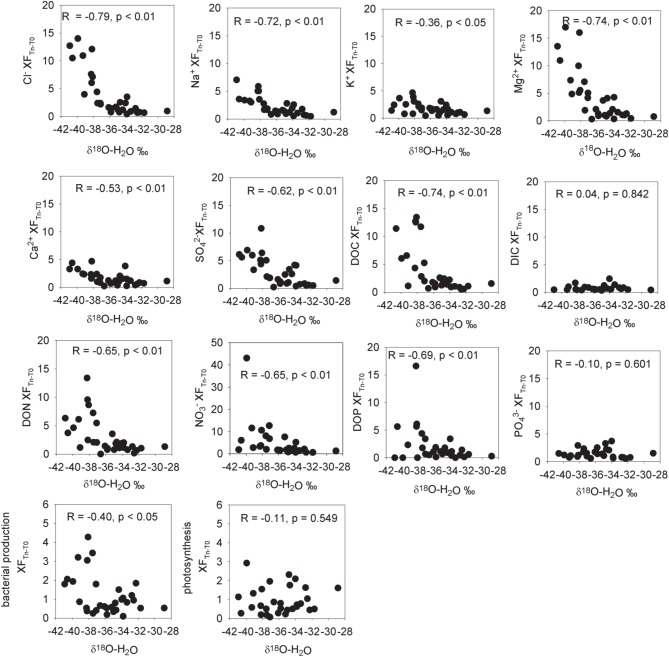
Enrichment factors (XF) for aqueous ions and cryoconite bacterial production and photosynthesis vs. δ18O-H20 (a measure of the % ice melt). Enrichment factors are the ratio of the measured aqueous concentrations of the ion to the mean concentration of that ion in initial frozen cryoconite holes. Statistics refer to Pearson correlation coefficients after taking the logarithm of the enrichment factor.